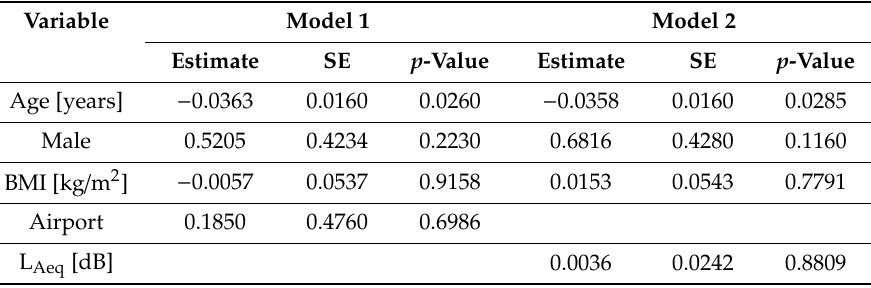
Table 4. Mixed model results for the sleep fragmentation